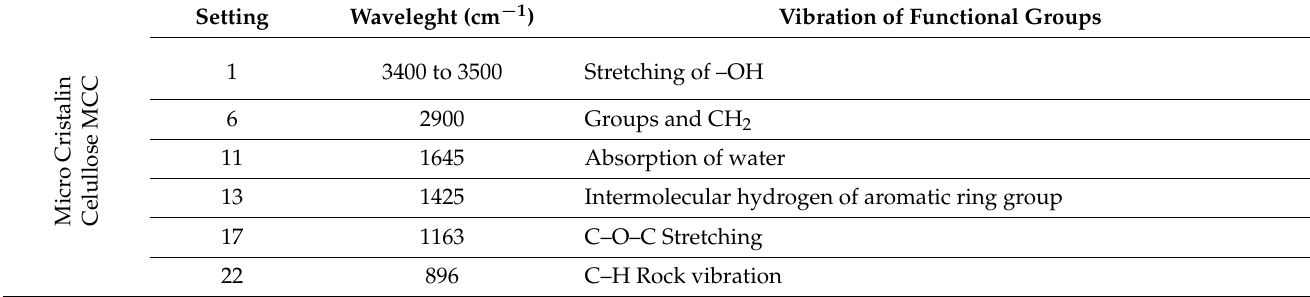
Table 1. FTIR functional